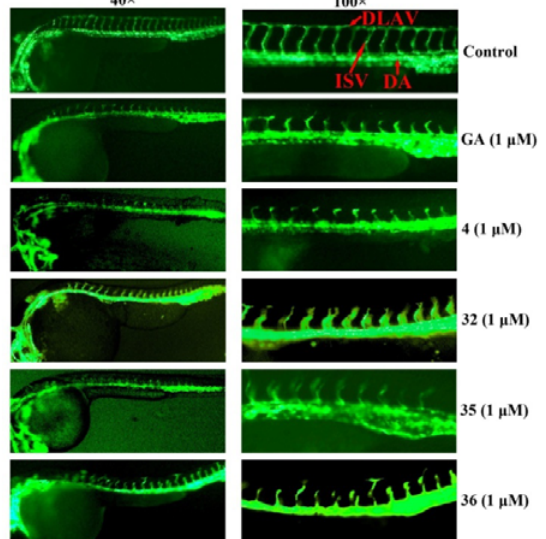
Figure 1. Effects on neovascularization in zebrafish embryos. The transgenic fli-1 : enhanced GFP zebrafish embryos in embryo water (0.2 g/L of instant ocean salt in distilled water) incubated with 1 μ M of compounds at 6 h postfertilization (hpf) for 24 h. Zebrafish embryos were imaged (Imager.Z1, magnification: left, 40×; right,